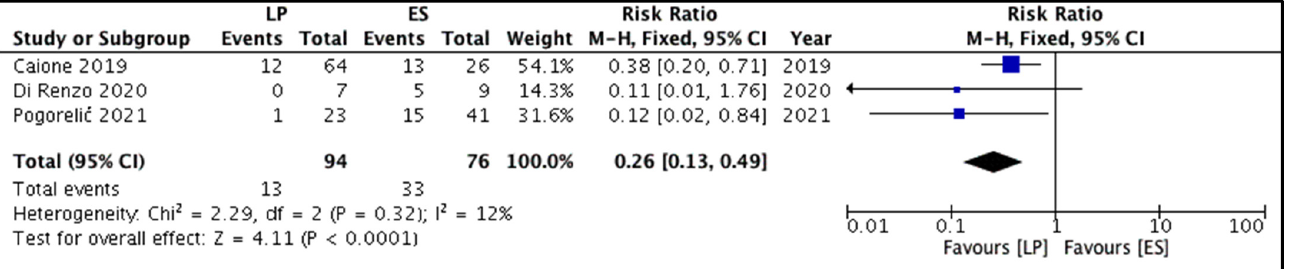
Figure 4. Forest plot comparison between the two patient groups in terms of the requirement for secondary surgical procedures. Legends: LP, laser puncture patient group. ES, electrosurgical inci- sion patient group. M-H, Mantel-Haenszel method. CI, confidence interval.